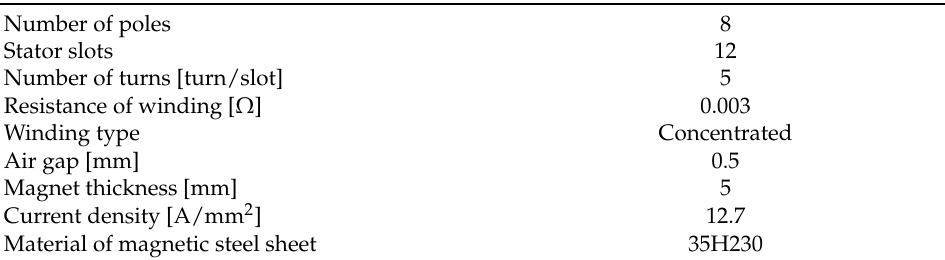
Figure 10. Dimension of designed SRM.